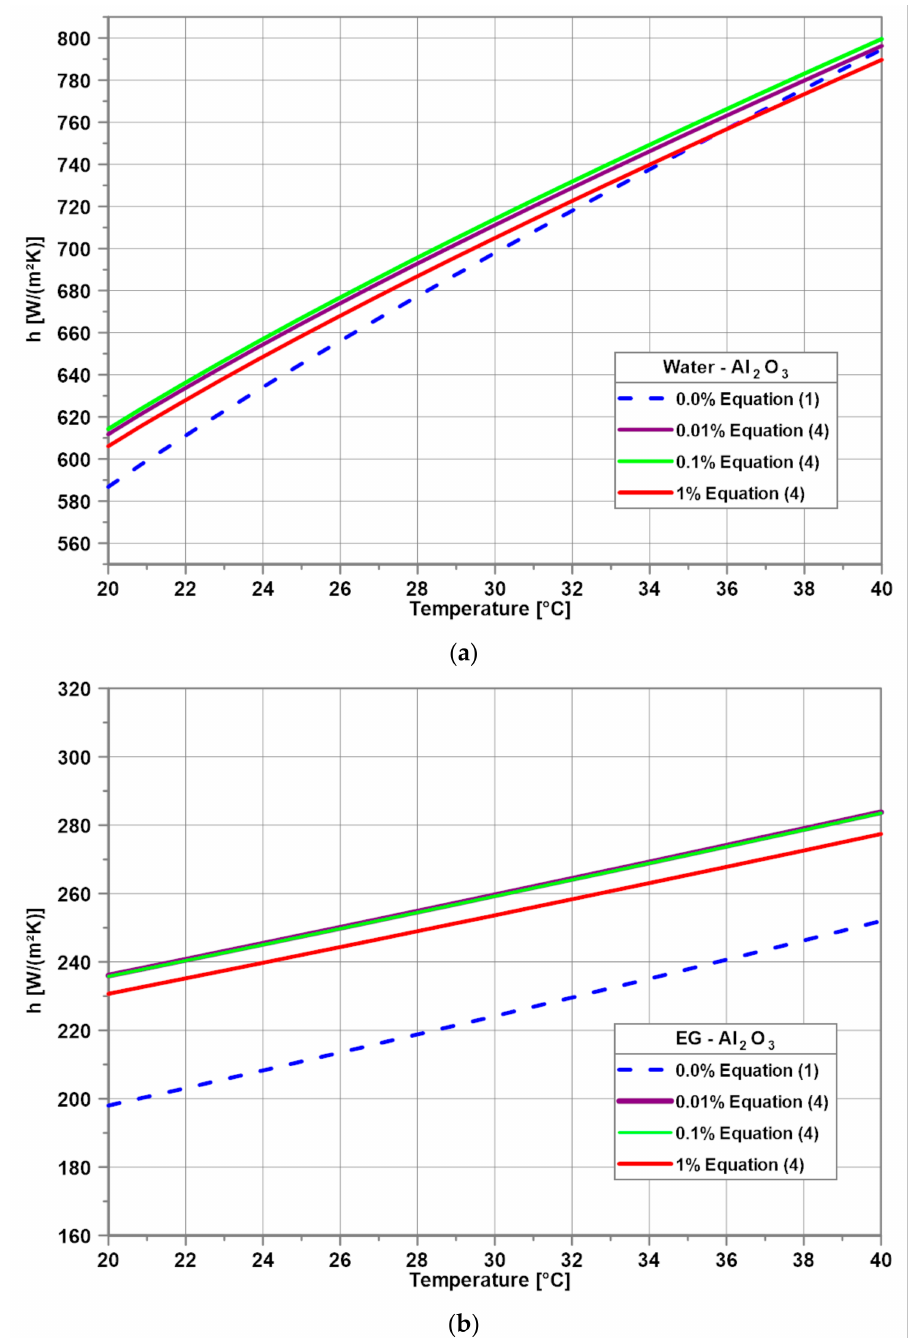
Figure 11. Impact of temperature and nanoparticle mass concentration on heat transfer coefficient for water-based ( a ) and EG-based ( b )